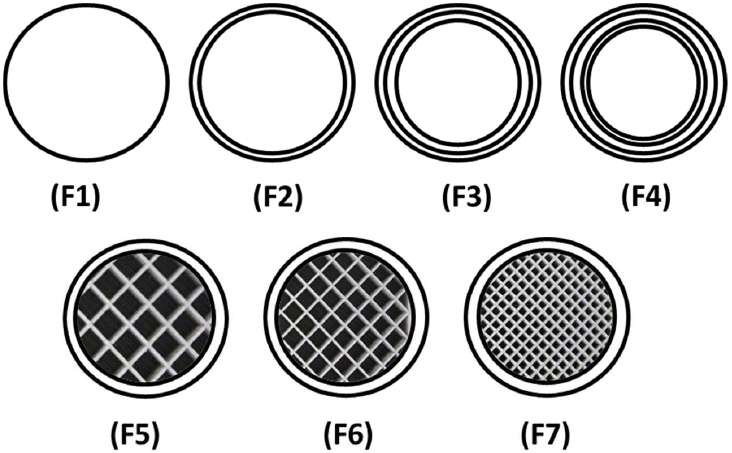
Figure 14. Schematic illustration depicting the cross-sectional view of 3D-printed matrix tablets